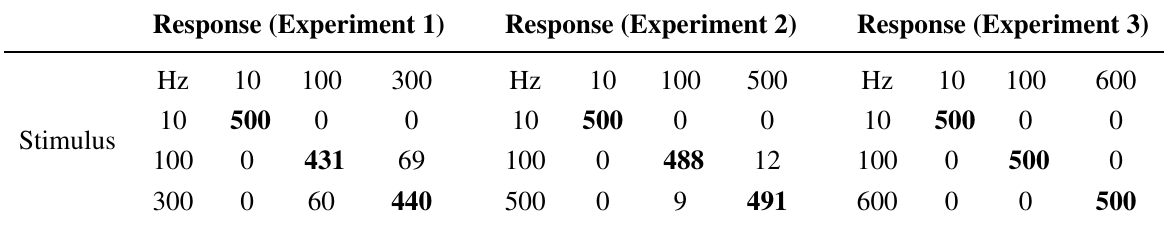
Table 3. Stimulus-response confusion matrices obtained through three repetitions of an frequency identification experiment with different sets of frequencies. Each cell shows accumulated responses from ten participants. Note that the max number “500” indicates perfect